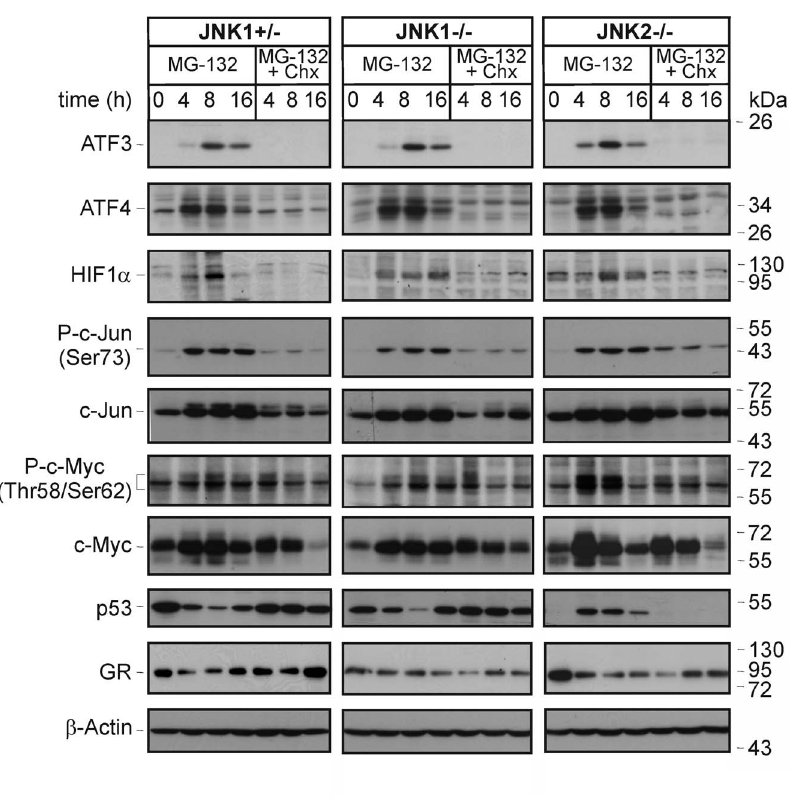
Figure 6. Influence of MG-132 on expression of transcription factors known to be involved in Noxa regulation. Western blot analyses for the indicated transcription factors and b -actin in the three MEF lines treated as indicated. One representative experiment out of three is